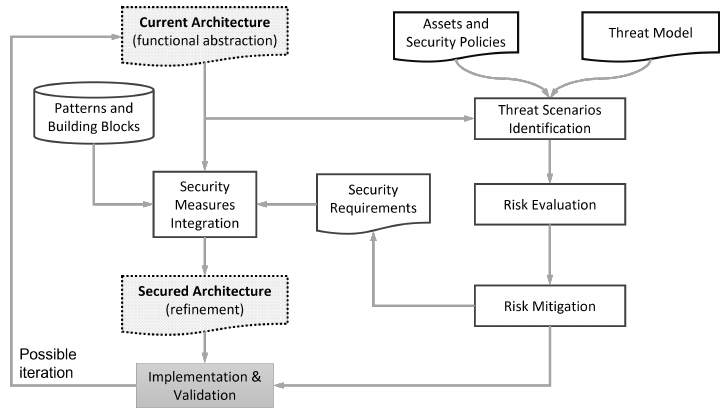
Figure 6. Migration and Integration